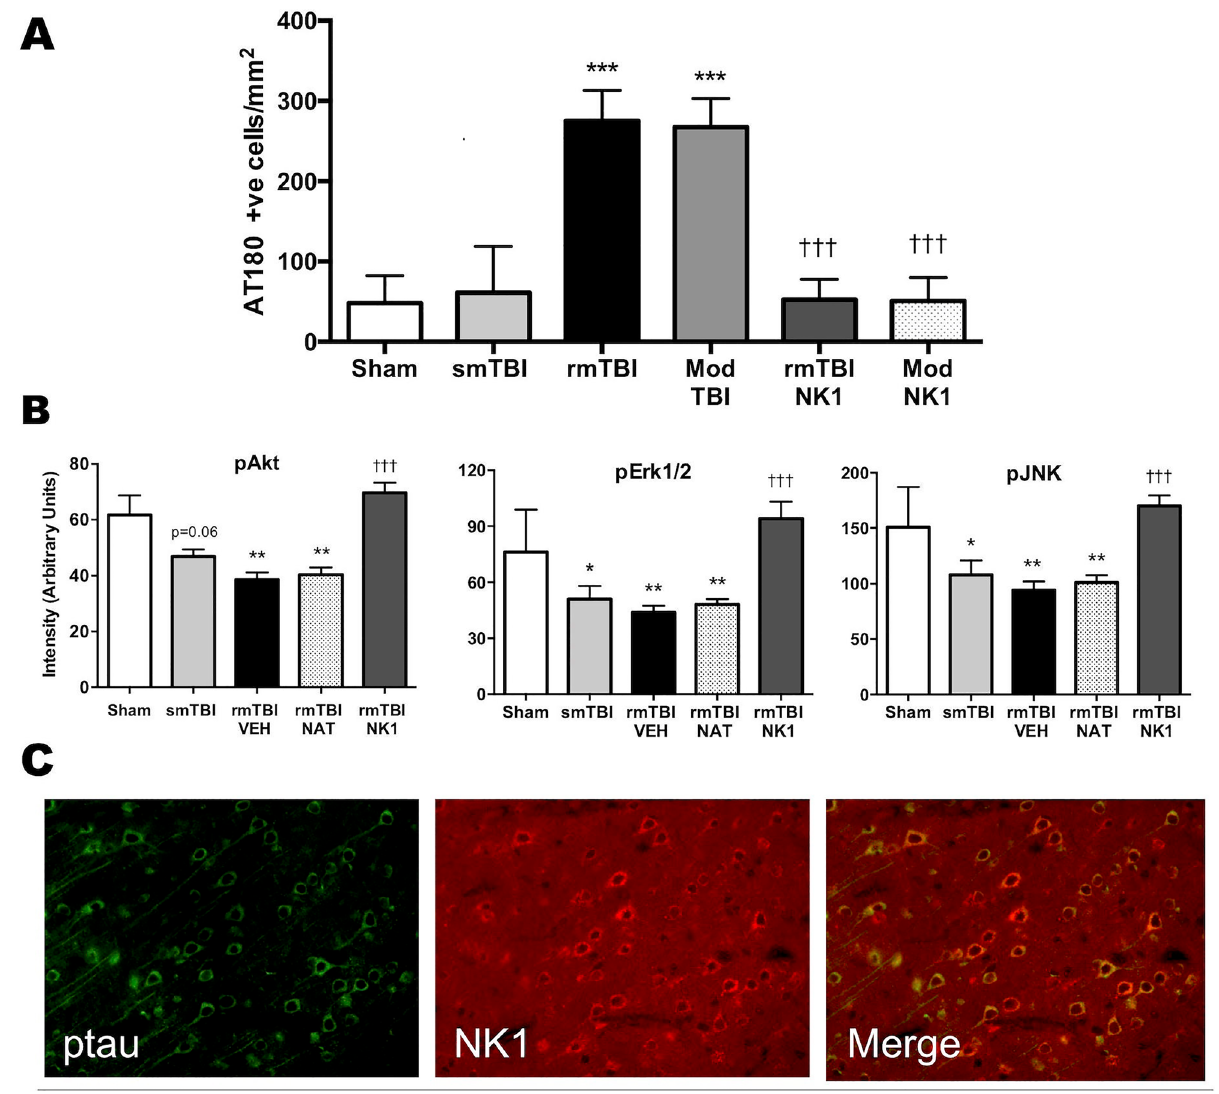
Figure 2. (A) Changes in cortical tau phosphorylation (AT180) at 24 h following single, mild TBI (smTBI), repeated mild TBI (rmTBI) or moderate TBI with and without NK1 antagonist (EUC-001) treatment. Mean ± SEM; n = 4–6/group; *** = p < 0.001 versus sham and smTBI; ††† = p < 0.001 versus no treatment. (B) Changes in phosphorylated kinase levels at 24 h following smTBI and rmTBI, with and without administration of the NK1 antagonist, EUC-001. NAT (n-acetyl-tryptophan) is a non, cell-permeable NK1 antagonist. Note that only the cell permeable NK1 antagonist EUC-001 returned post-injury phosphorylated kinase levels back to sham (non-injured) levels. Mean ± SEM; n = 5–6/group; * = p < 0.05, ** = p < 0.01 versus sham; ††† = p < 0.001 versus vehicle and NAT treated animals. (C) Typical confocal microscopy images of cortical neurons expressing phosphorylated tau (AT180), NK1 receptors, and their colocalization in the merged image. Images were obtained at 24 h following a single moderate